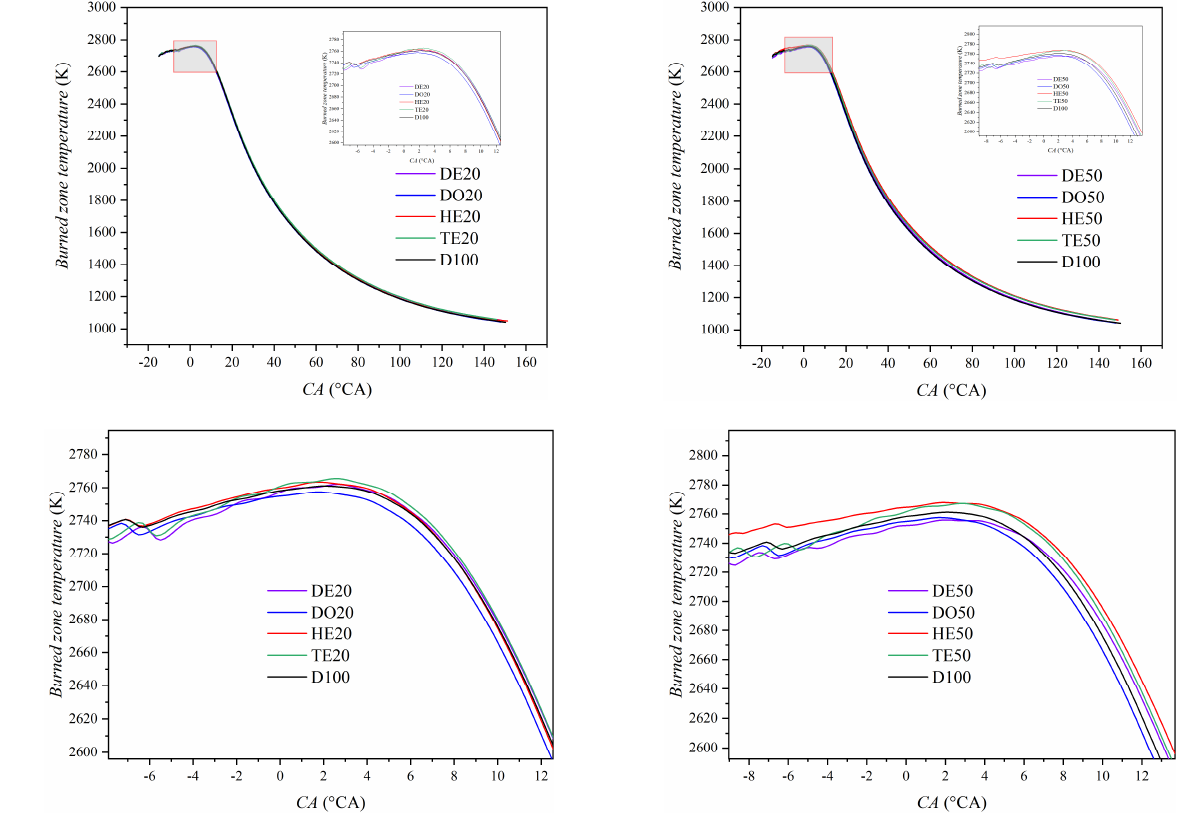
Figure 12. The burned zone temperature versus crank angles at 1900 rpm.